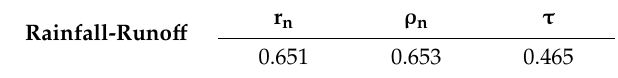
Table 1. Rainfall-runo ff correlation coe ffi cients for the Rasht